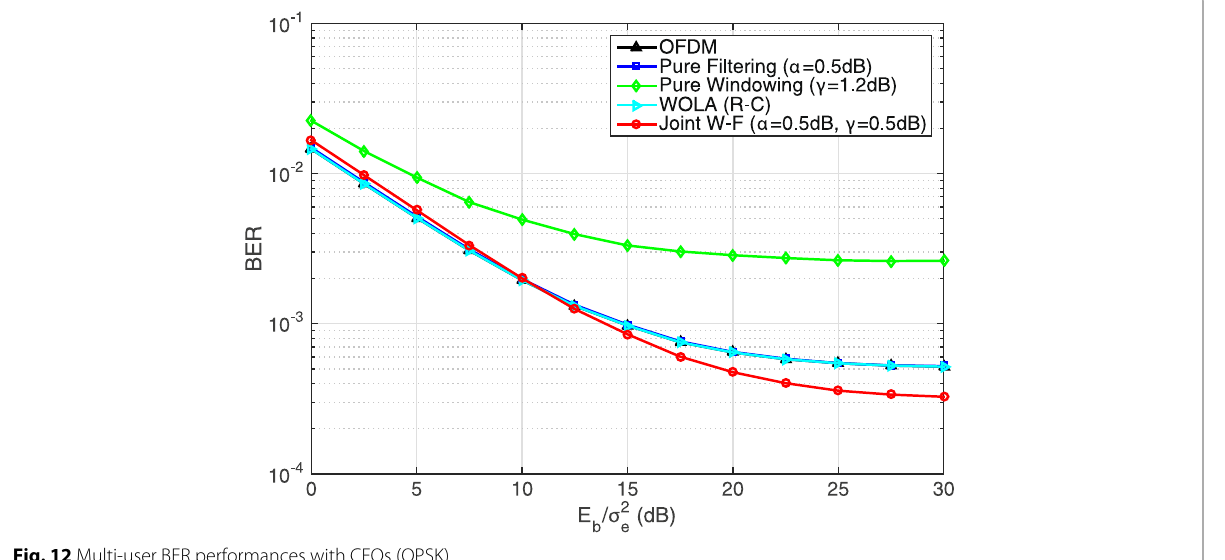
Fig. 12 Multi-user BER performances with CFOs (QPSK)